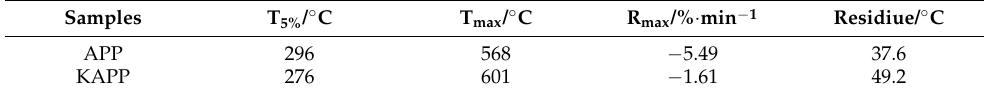
Table 6. TGA data of APP and KAPP.